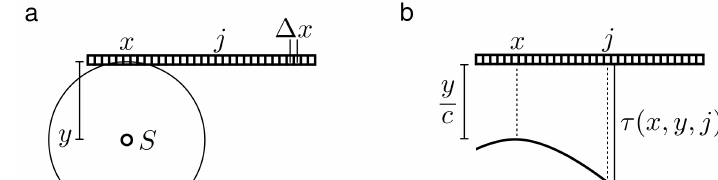
Figure 1. ( a ) Illustration of a signal S originating at depth y and lateral position x relative to a transducer array with example element j and propagating as a spherical acoustic wave with speed c ; ( b ) Illustration of the same scenario in the time domain of pressure recorded in the transducer array (radio frequency (rf) data), where τ ( x , y , j ) denotes the propagation time of that signal S